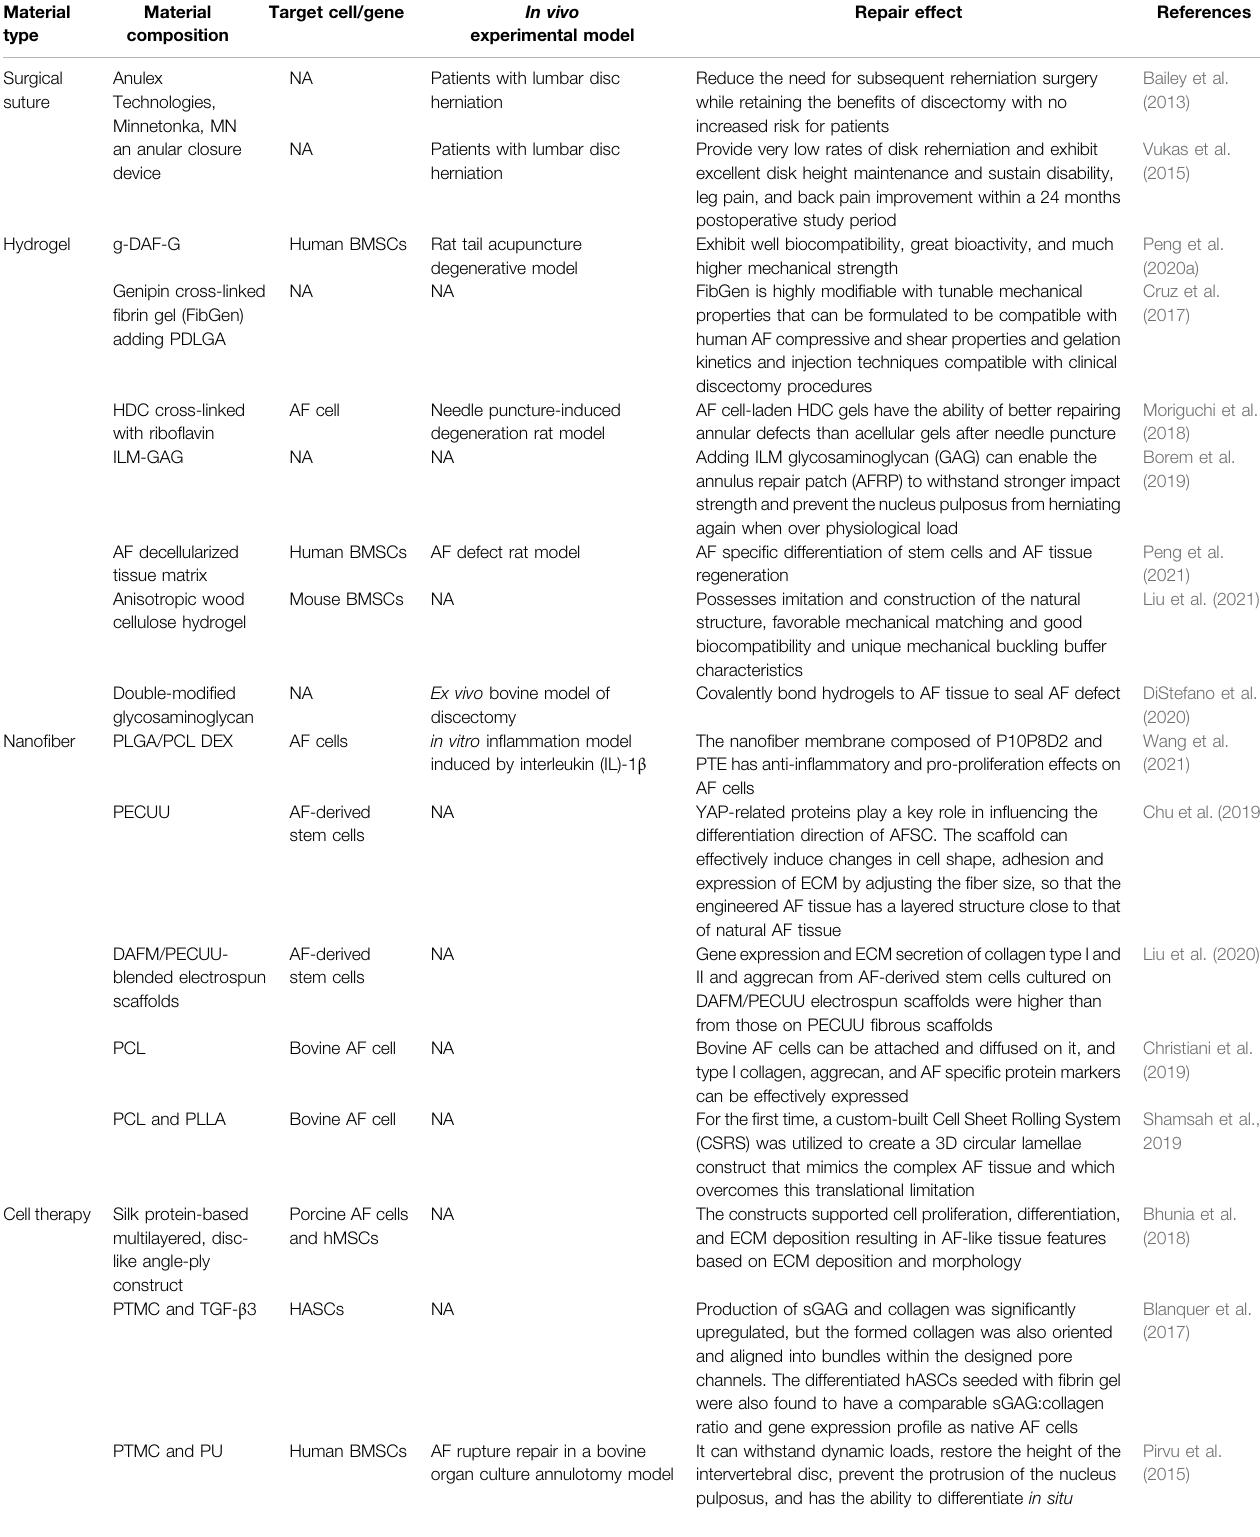
TABLE 2 | Summary of various biomaterials for AF repair and their